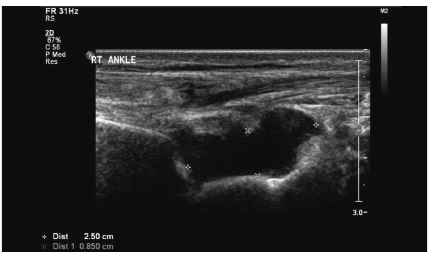
Figure 2: US of (R) ankle showing moderate effusion (3.8 cc).